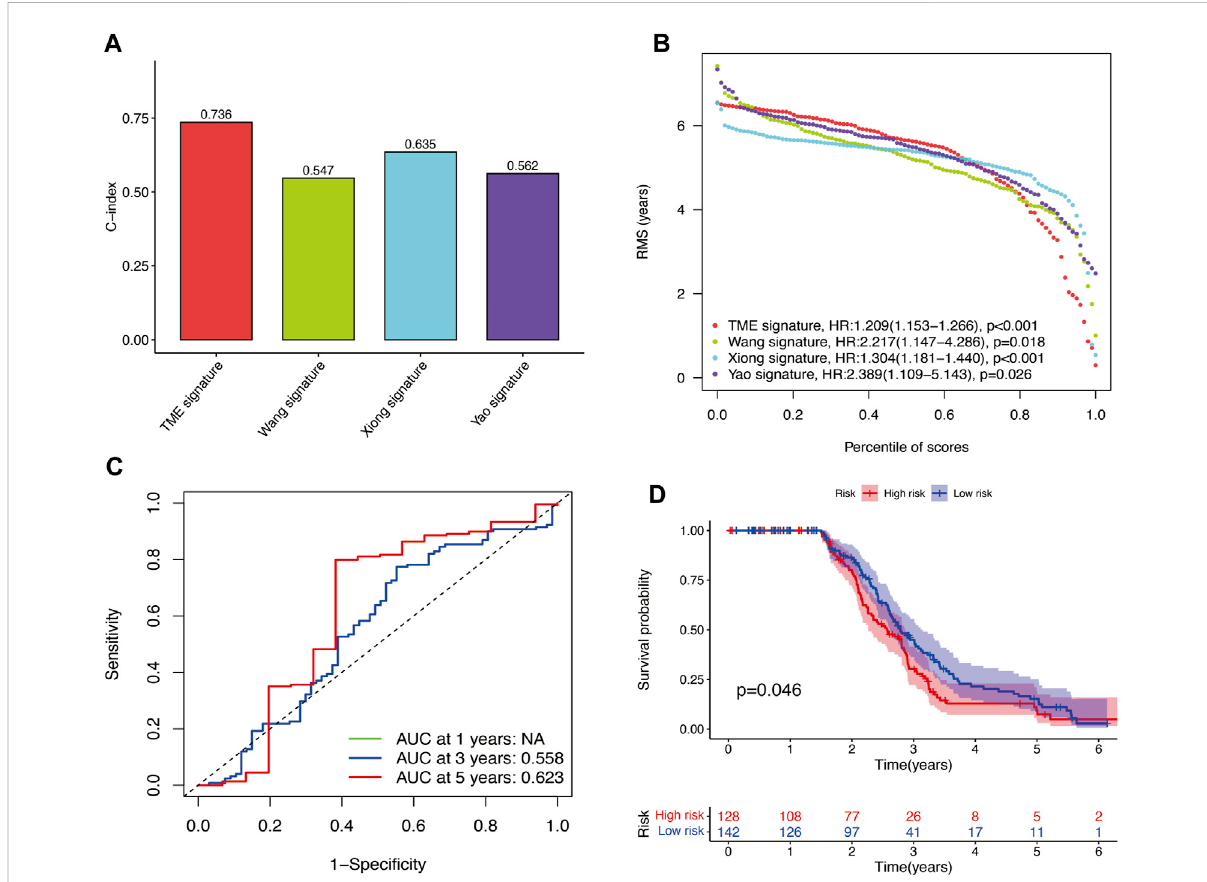
FIGURE 10 (A – B) C-index results andpercentileofscores ofthefourdifferentsignatures. (C) AUC values forpredicting1-, 3-,and 5-year OS forpatients